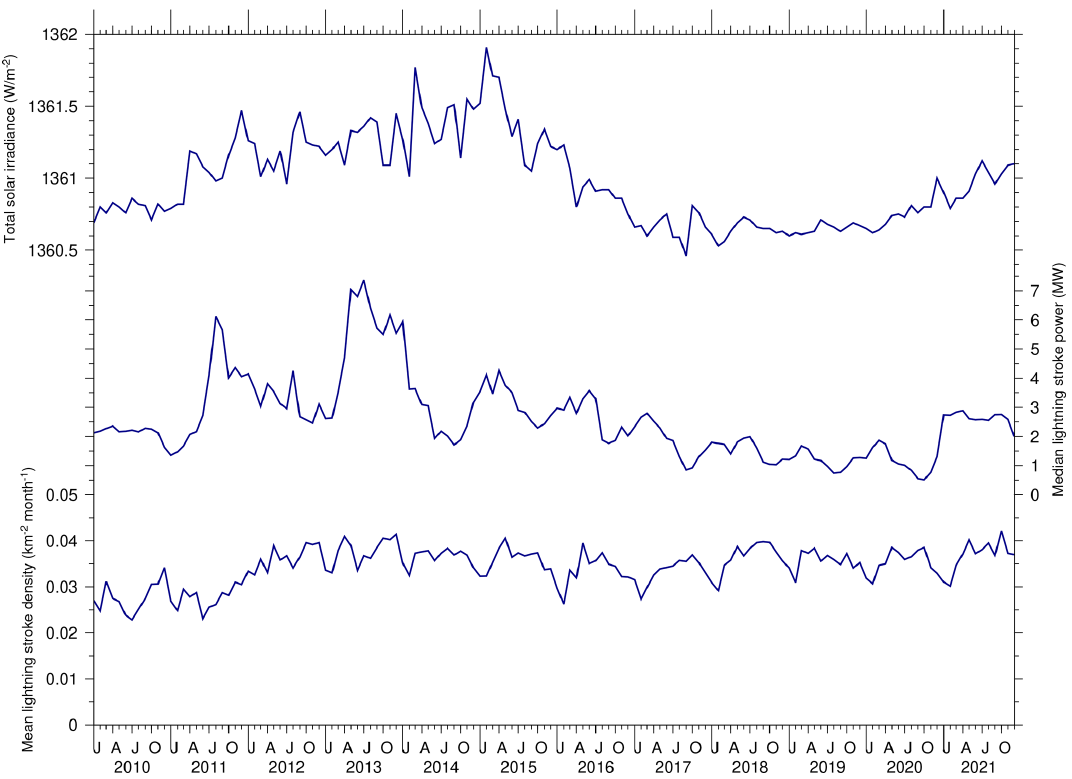
Figure 4. Time series of total solar irradiance (TSI; LASP, 2022), monthly median of WGLC global lightning stroke power, and monthly mean global lightning